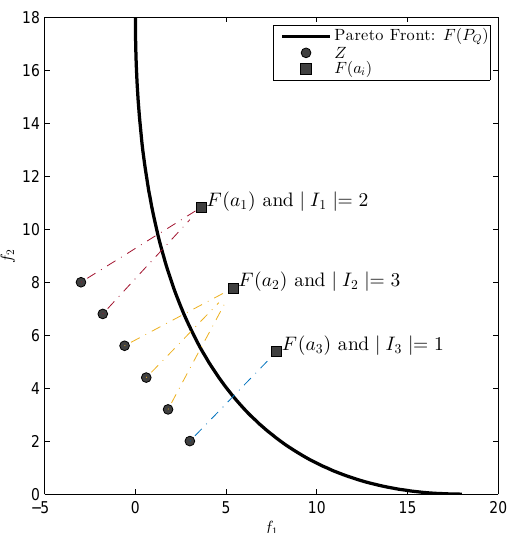
Figure 4. Example of a relation between the reference set Z and the approximation set F ( A ) .